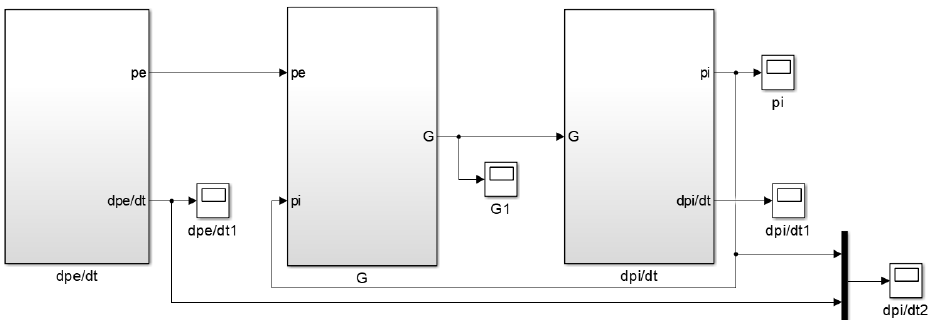
Figure 2. Simulation model of pressure change rate for the air metal container.